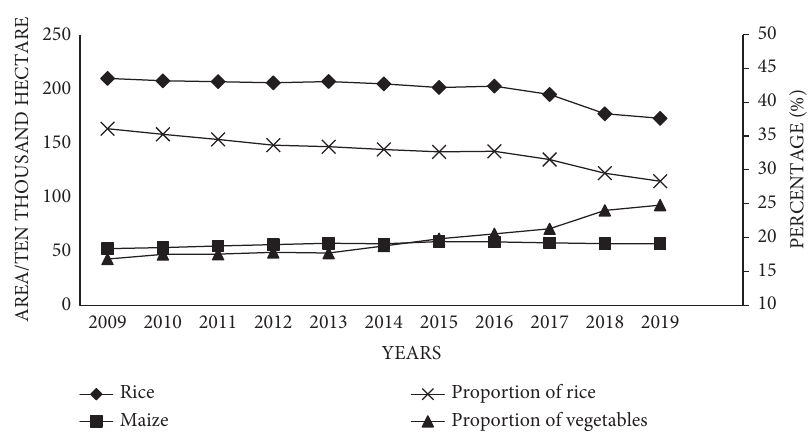
Figure 4: Change of main grain crop area in Guangxi from 2009 to